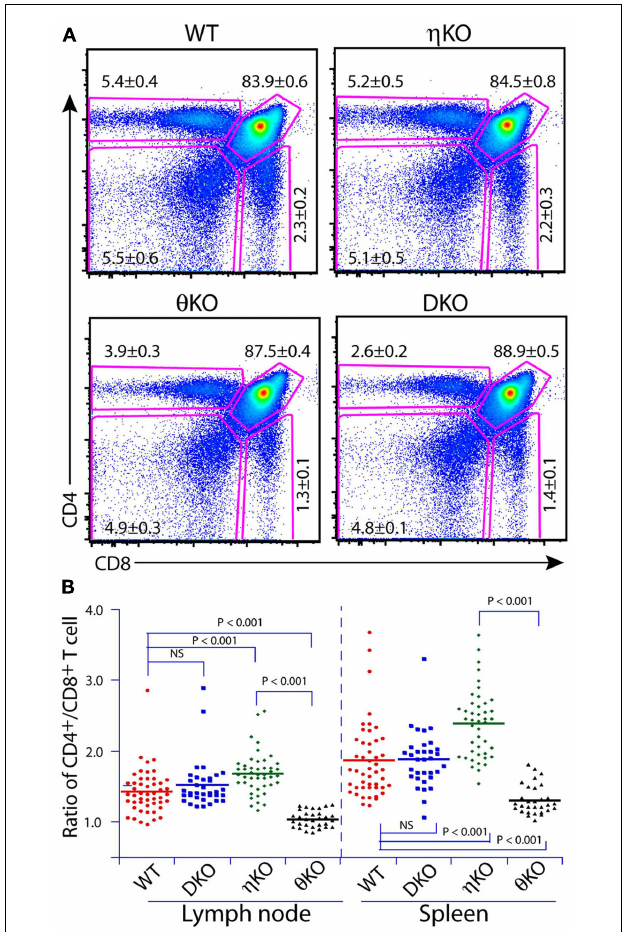
FIGURE 4 | Redundancy and isoform-specific role of PKC η and PKC θ in T cell development. (A) Redundant role of PKC η and PKC θ is revealed by phenotypingT cell development in the thymus of double-knockout mice. (B) Isoform-specific role of PKC η and PKC θ is revealed by the CD4/CD8T cell ratio in the periphery. Adapted from Fu et al.